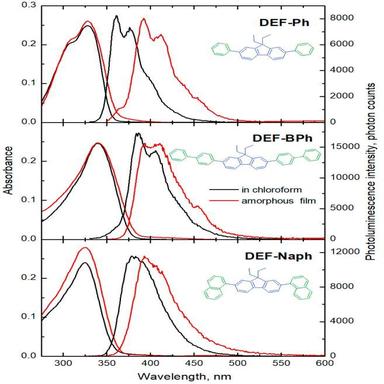
Absorption and photoluminescence (λex = 300 nm) spectra of DEFs: solutions of DEF-Ar in chloroform (black line) and DEF-Ar-amorphous films (red line).